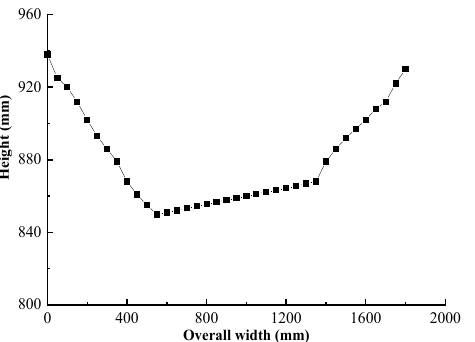
Figure 30. The overall compression amount of specimen 2 along the width direction. The vertical deformation of the shear infill panel is shown in Figure 31. The out-of- plane displacement of infill panel along the width direction, and the height corresponding to the maximum out-of-plane displacement as well as the deformation at the middle part of infill panel are shown in Figure 32. It can be seen from the figure that the maximum out-of- plane displacement of the infill panel emerged in the middle and upper part, which showed out-of-plane bulging in the width direction with the maximum out-of-plane deformation of 95 mm at the center of the infill panel.